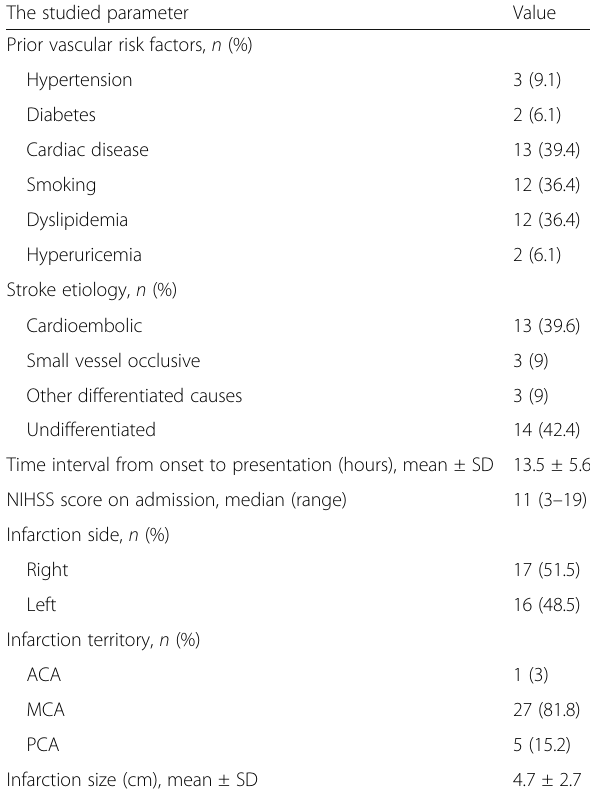
Table 2 The patients ’ ( n = 33) demographic and baseline clinical and radiological